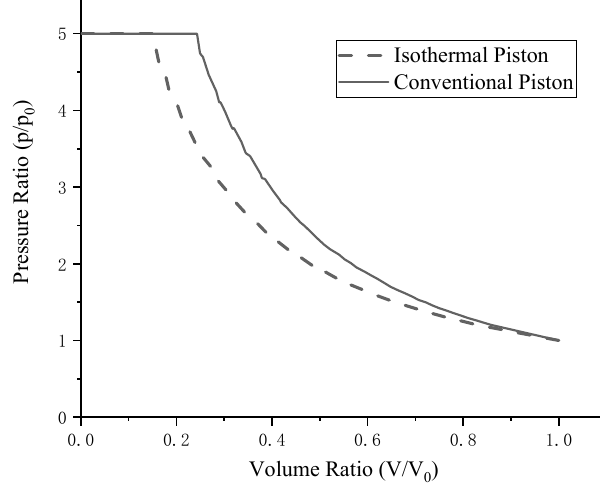
Figure 11. p-V diagram for the contrast compression experiments.